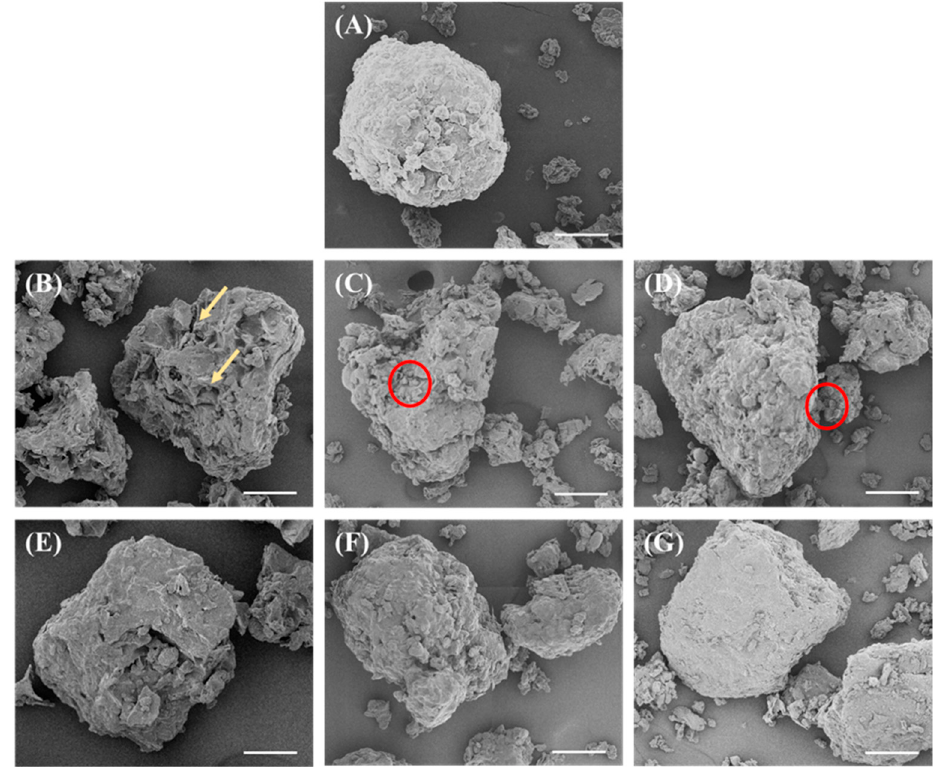
Figure 2. SEM images for defatted soy meal (DFSM) ( A ) and aqueous ethanol-washed soy protein concentrates (SPCs) with water/ethanol ratios of 0% ( B ); 20% ( C ); 40% ( D ); 60% ( E ); 80% ( F ); and 100% ( G ). The scale bar is 50 µm. The yellow arrow and red circle represent cellular matrix and protein body, respectively.